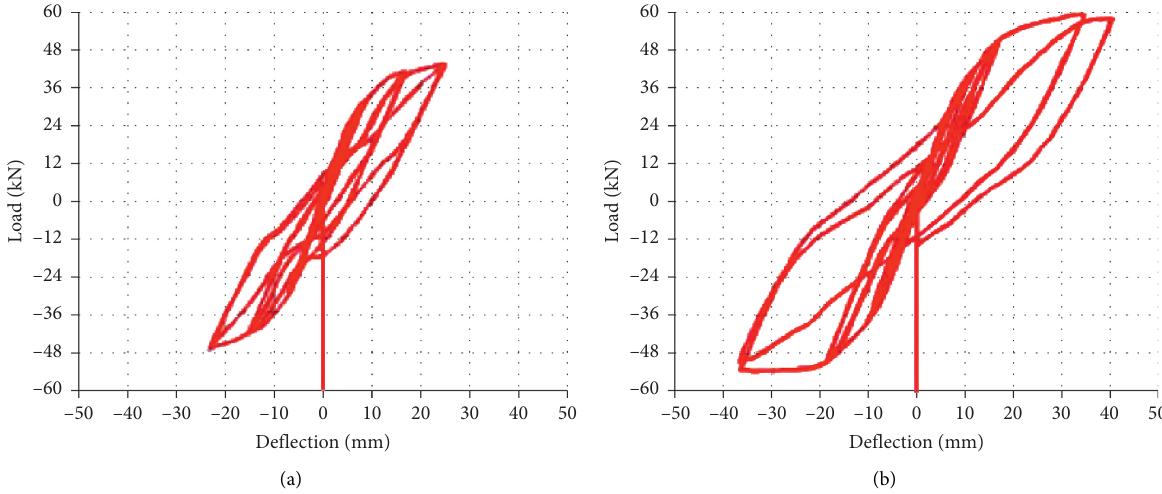
Figure 7: Comparison of the hysteretic curves of model 2 (analysis results): (a) before reinforcement; (b) after reinforcement.